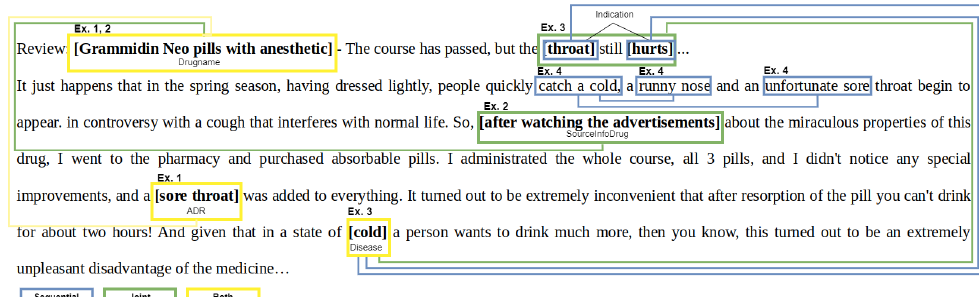
Figure 3. An example of predictions for both approaches with XLMR-sag on translated part of the text #517 from RDRS dataset (models are fine-tuned on the extended version of the dataset). Here, blue boxes are related to the sequential approach, green—to the joint, yellow—to both approaches. Ex. 1. Both approaches have the correct prediction on relation between “Grammidin Neo pills with anesthetic” and “sore throat”—adverse effect; Ex. 2. Joint model has correct prediction on information source, leading to correct relation prediction. Sequential approach did not predict “after watching the advertisements” entity of type SourceInfoDrug; Ex. 3. Joint model included additional words in the Indication entity (“throat still hurts” instead of “throat ...hurts”), sequential predicted two entities in place of one (“throat” and “hurts” separately, resulting in two incorrect predicted relations); Ex.